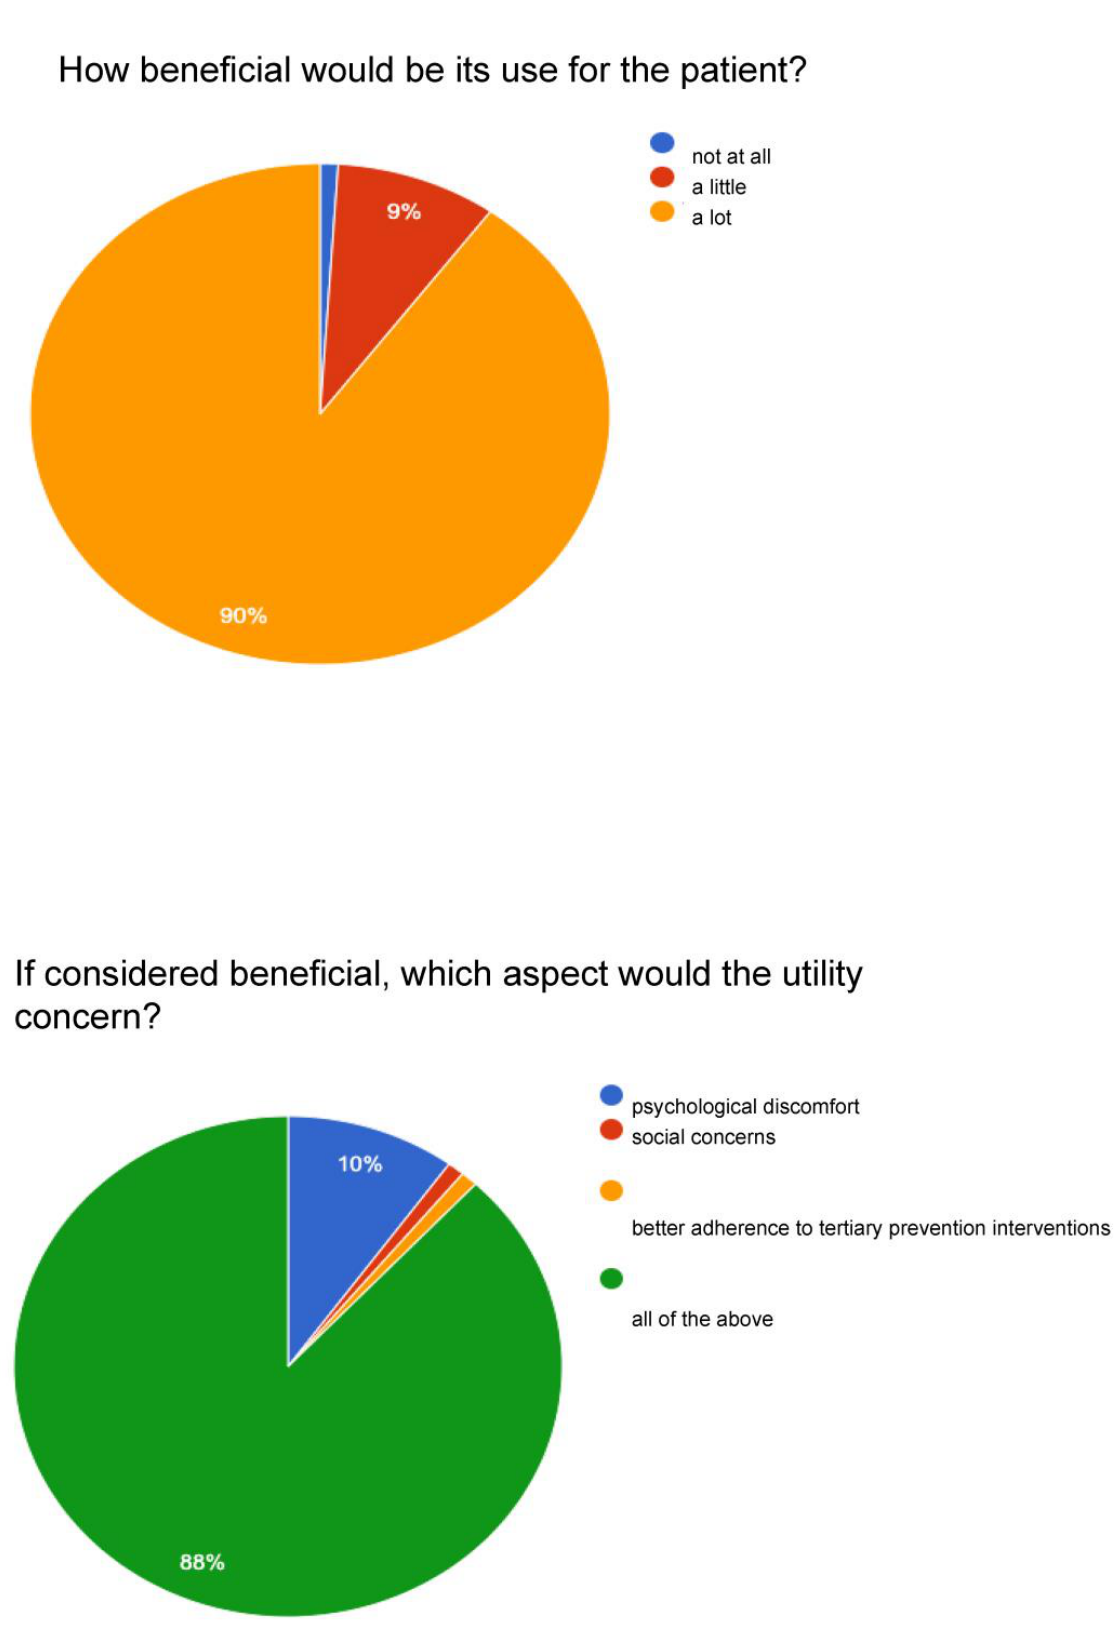
Figure 4. Surgeons. Figure 4.